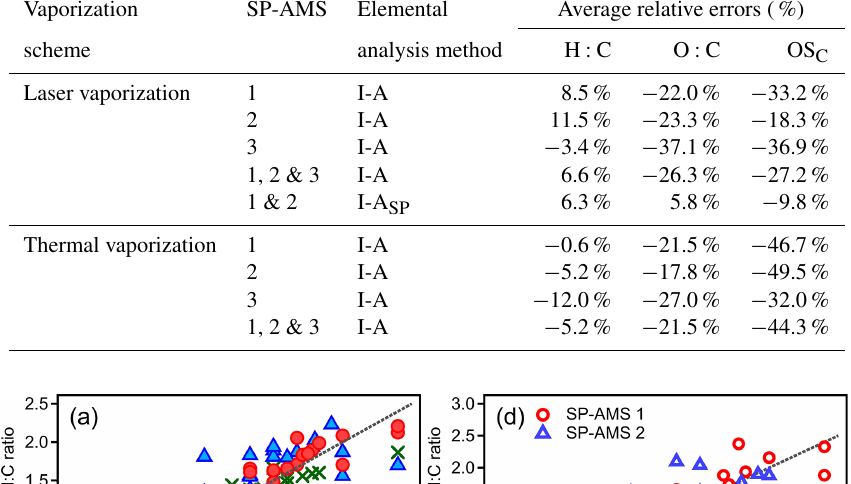
Table 2. Relative errors of H : C, O : C, and OS C measured by the three independent SP-AMSs.